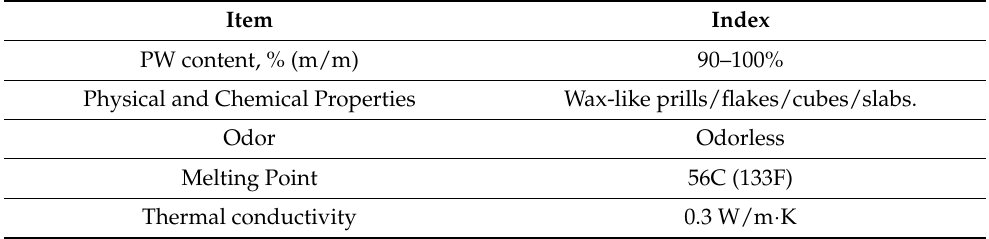
Table A3. Thermal properties of paraffin wax